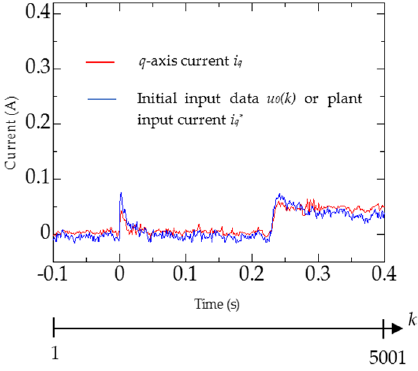
Figure 9. Initial input data u 0 ( k ) and q -axis current i q .